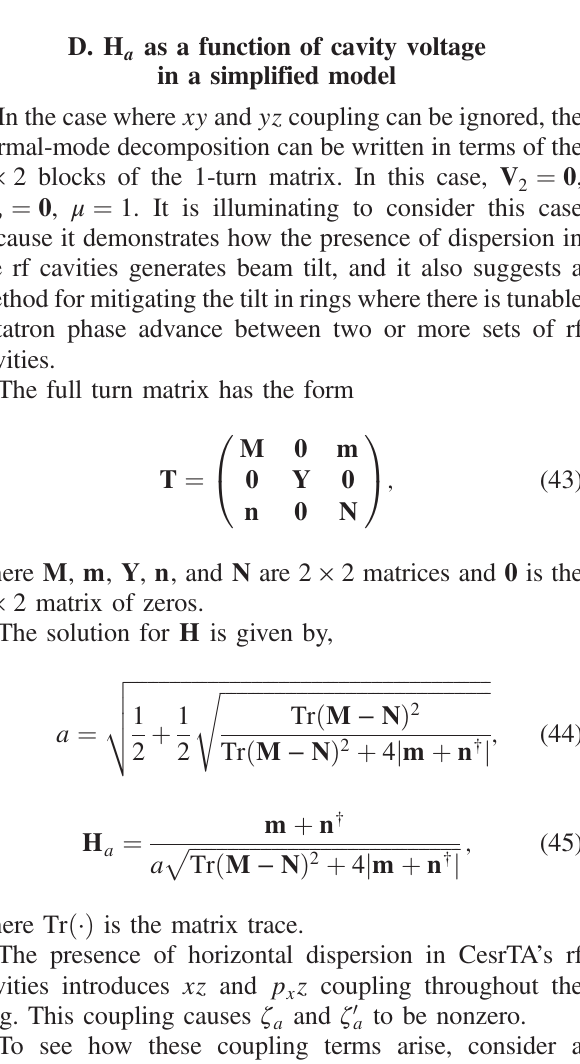
FIG. 2. Projection of the beam envelope into the xz plane with a crabbing angle of − 15 mrad. The green arrow is the major axis of the ellipse. The red arrow is crabbing angle obtained from the HVBP parametrization. Note that the horizontal and vertical axes have very different scales in order to make the beam tilt discernible; a side effect is to make it appear as if the green arrow is not along the major axis.